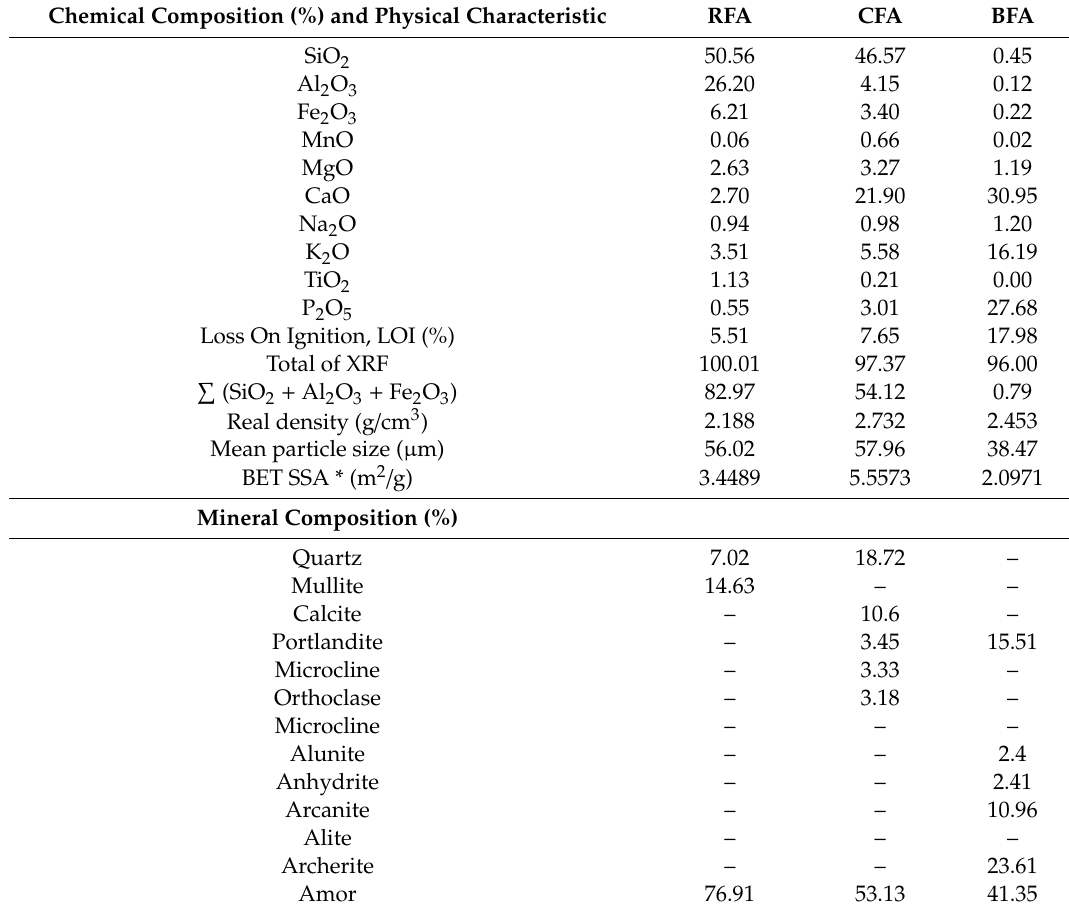
Table 2. Raw material